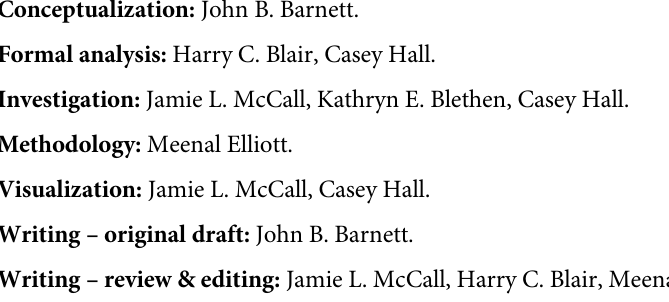
S4 Fig. Prenatal Cd exposure does not induce ANA in SKG model. Serum autoantibodies were measured by ANA Hep Screen ELISA. S5 Fig. SKG mice body weight at time of induction and AI of left rear paws. A) Body weights of male and female mice at the time of arthritis induction with zymosan A. Symbols represent the data for individual mice and the black bar denotes the median. B) Left rear paw arthritic indices. No differences were noted between control and cadmium exposure within each sex. Data are shown as mean ± SEM. S6 Fig. BMD analysis of the femurs of arthritic Control and Cd-exposed SKG offspring. Bone mineral density (BMD) was measured at the distal femur using the same Volume of Interest (1.05 mm) following calibration with calcium hydroxyapatite phantoms of known density: 0.25 and 0.75 g/cm 3 . Phantoms were prepared, scanned, and reconstructed with the same parameters as Fig 7. Data are shown as mean ± SD. S1 Table. Raw data used for graphs presented as means.